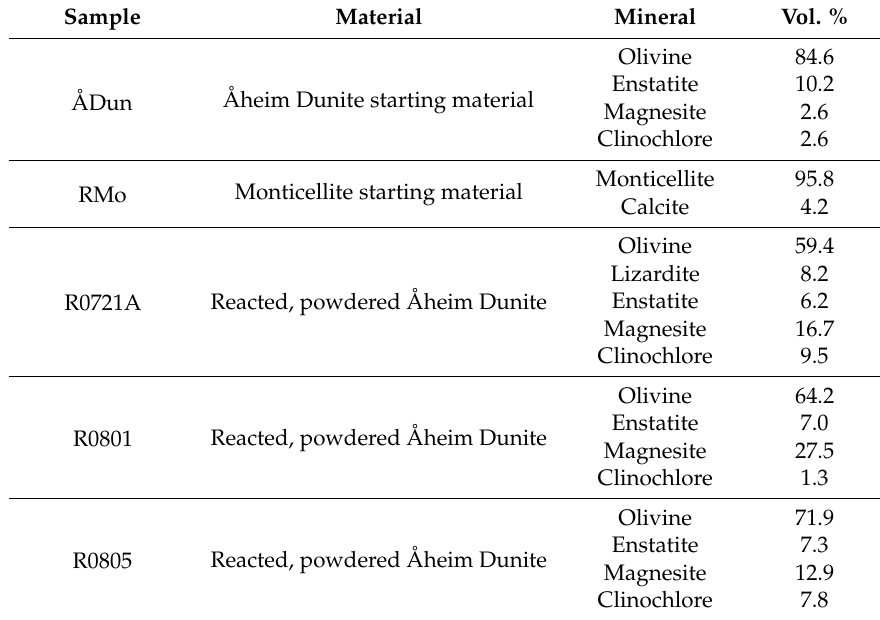
Table 8. Best-fit mineral compositions derived from XRD-analyses performed on starting materials, reacted samples and precipitates. The uncertainty and detection limit of these analyses are ~ ± 10%.